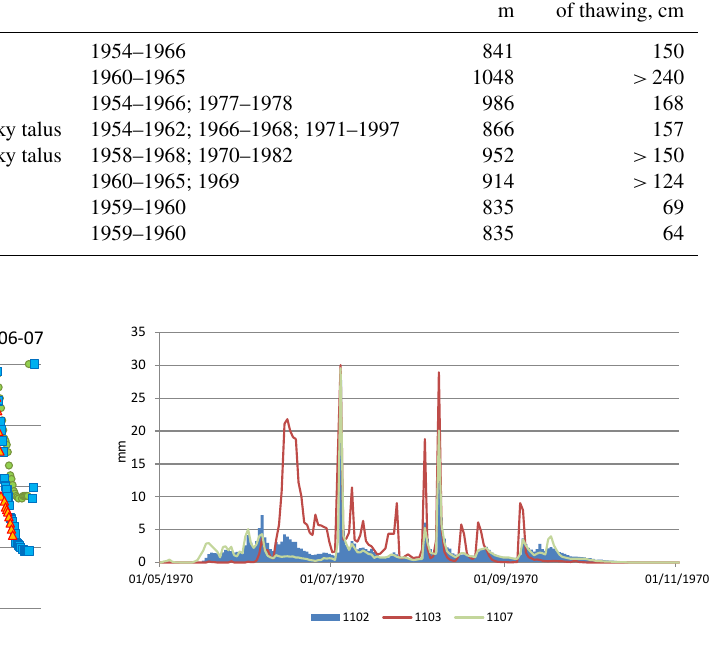
Figure 14. Flow depth (mm) at the Kontaktovy creek – Nizhny (1102), Severny brook (1107) – south-facing slope with cedar dwarf bush landscape, and Morozova brook (1103) – rocky talus land- scape at watershed divides,